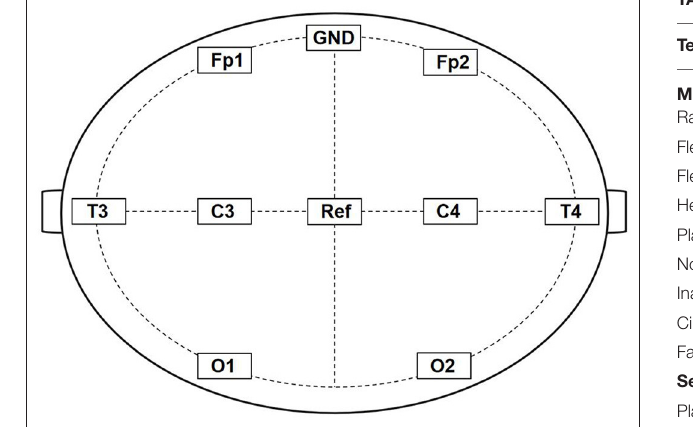
TABLE 1 | Modified neurological severity score